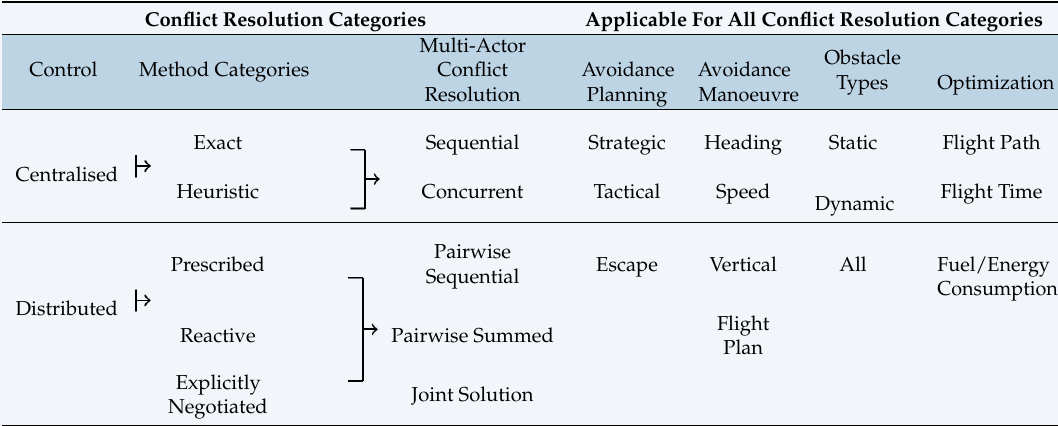
Table 2. Taxonomy of conflict resolution categories.